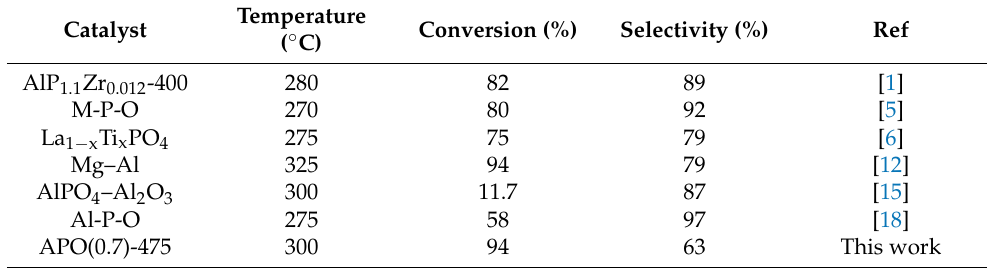
Figure 5. Effect of reaction time on ( a ) catechol conversion and ( b ) guaiacol selectivity over the APO catalysts with different P/Al molar ratios; the inset in ( b ) is the guaiacol selectivity at ~30% conversion of catechol. Reaction condition: 3 g APO catalyst, molar ratio of catechol to DMC = 1:6, 300 ◦ C, liquid hourly space velocity (LHSV) = 0.4 h − 1 . Table 2. O -methylation of catechol to guaiacol over our proposed APO(0.7)-475 catalysts and recently documented